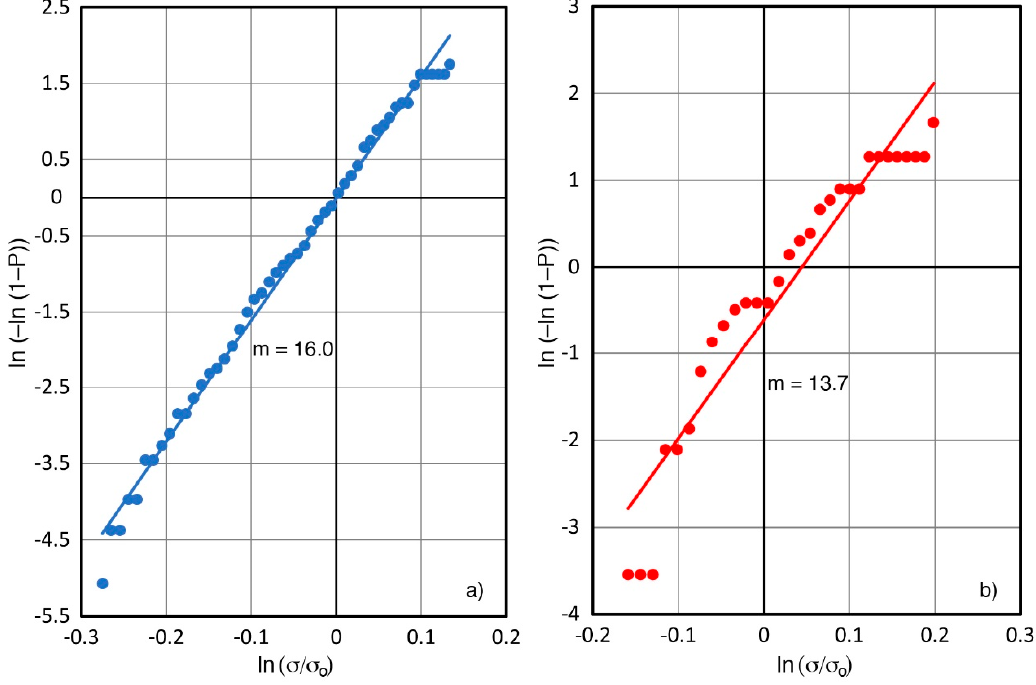
Figure A1. Weibull plots for steel wires. ( a ) Williamsburg Bridge (1903), data from [78], ( b ) Percy (1886), data from